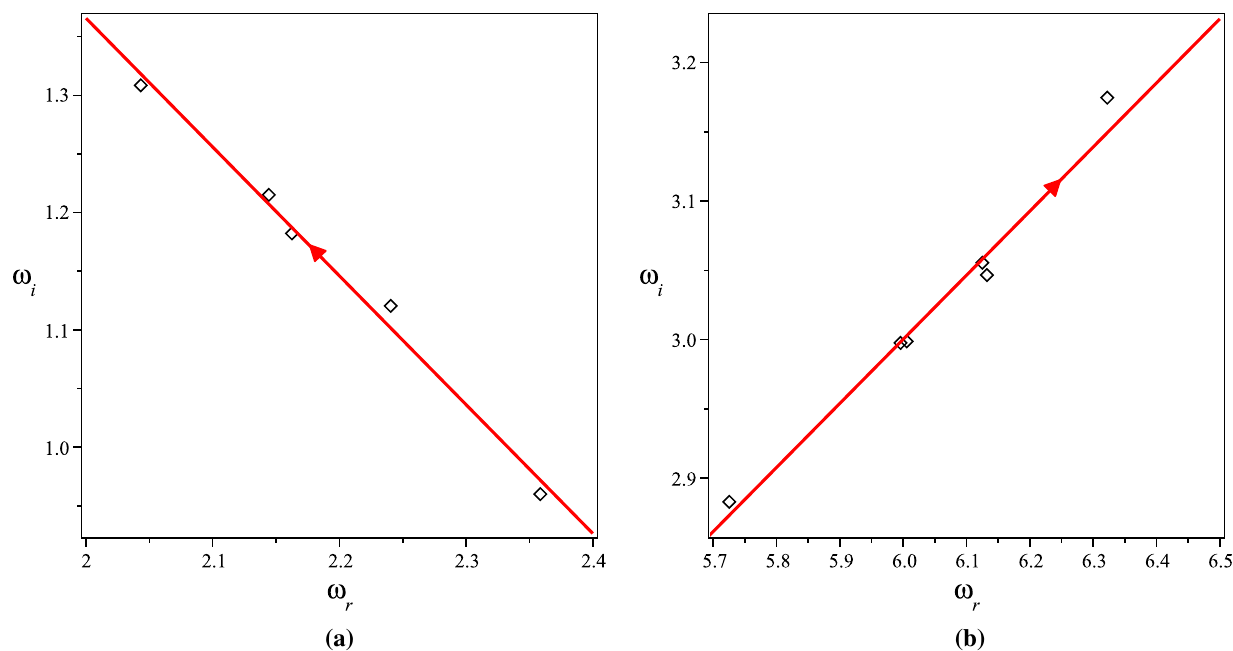
Fig. 15 The behavior of quasinormal modes for small black holes (left) and for large black holes (right). The arrow indicates the increase of black hole horizon 2 α r + O ( r 2 ) as r → 0. The behaves like f ( r ) ≈ 1 − β 2